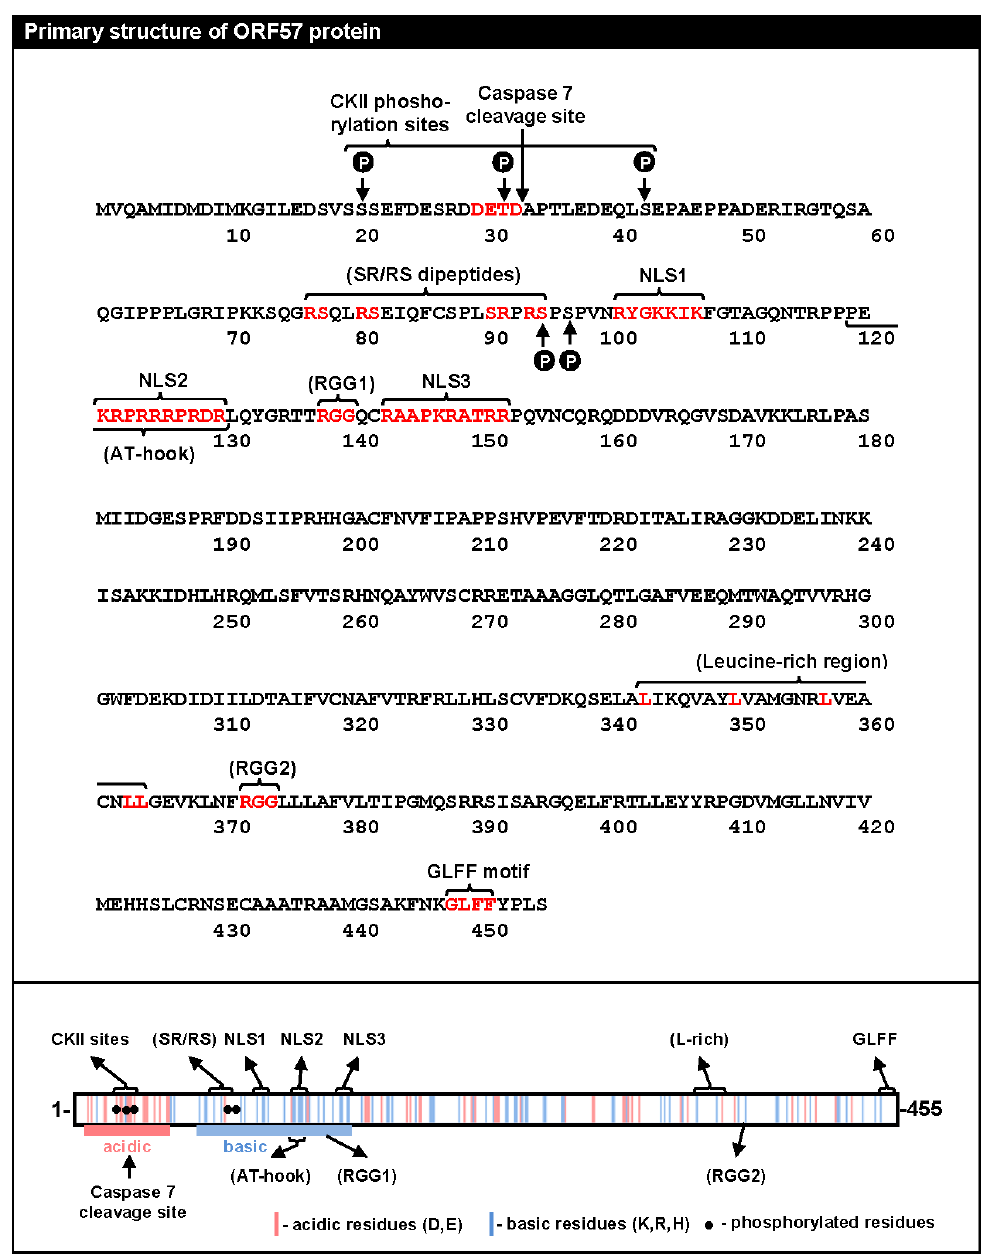
Figure 1. Protein sequence and putative motifs of ORF57. (Top) The amino acid sequence of ORF57 with putative motifs indicated with brackets and the residues making up the motifs shown in red. Phosphorylation sites (P in black circle) are also indicated. (Bottom) A summary of the primary structure of the ORF57 protein (aa 1–455) with the distribution of acidic (red lines, D: aspartic acid, E: glutamic acid) and basic (blue lines, K: lysine, R: arginine, H: histidine) amino acids. The linear motifs identified based on the analysis of the ORF57 aa sequence are shown above and below (CKII-casein kinase II, SR/RS-serine/arginine and arginine/serine dipeptides, NLS-nuclear localization signal, L-rich-leucine-rich domain, GLFF motif-glycine/leucine/phenylalanine/phenylalanine motif, AT hook-adenine-thymine hook, RGG-arginine/glycine/glycine). The functionally unconfirmed putative motifs are in parentheses. The filled circles represent the mapped ORF57 phosphorylation